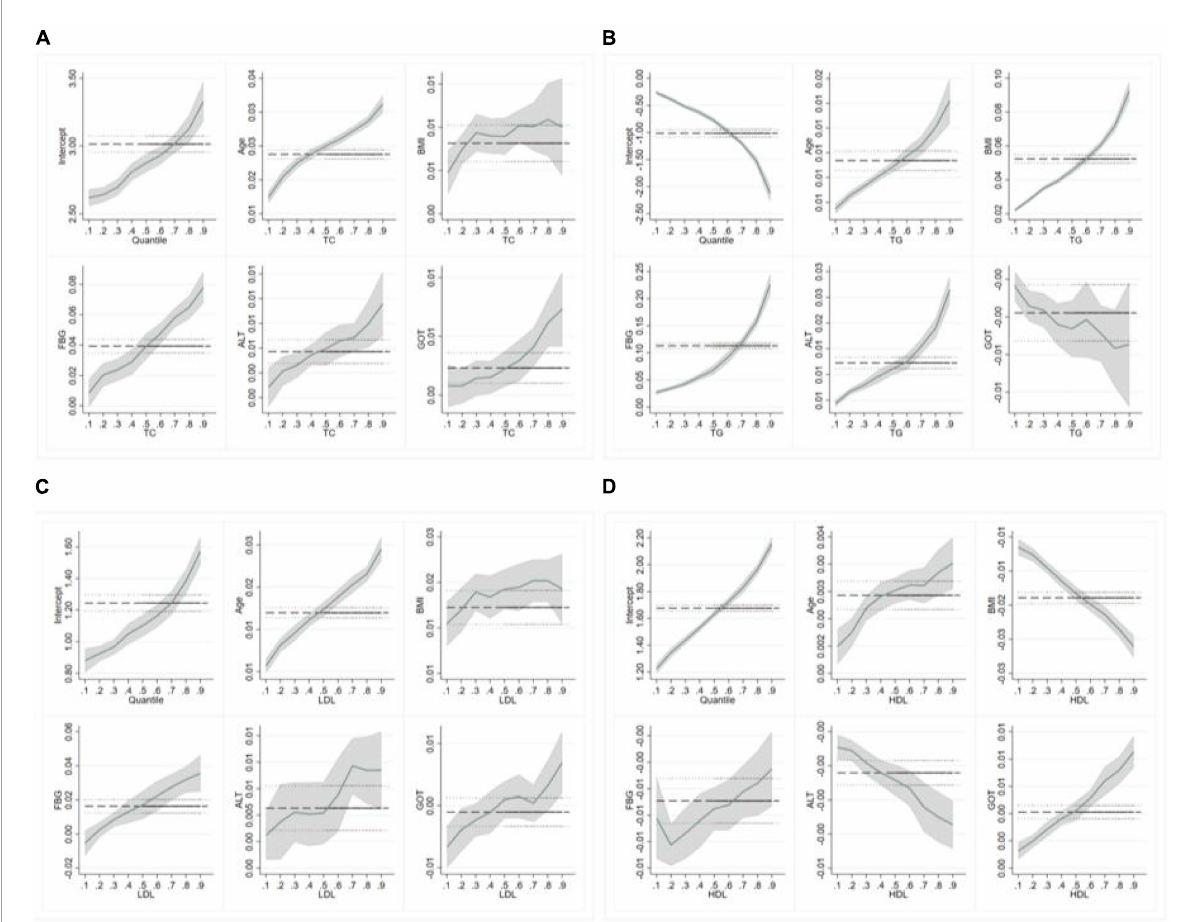
FIGURE4 Quantile regression (QR) results for lipid levels (females). (A–D) Represent the quantile regression results of TC, TG, LDL-c, and HDL-c levels,